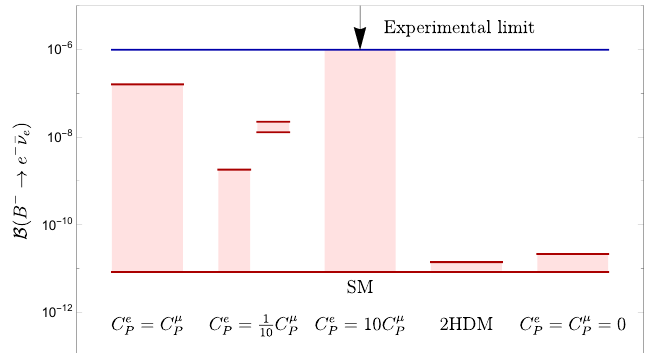
) for the scenarios e